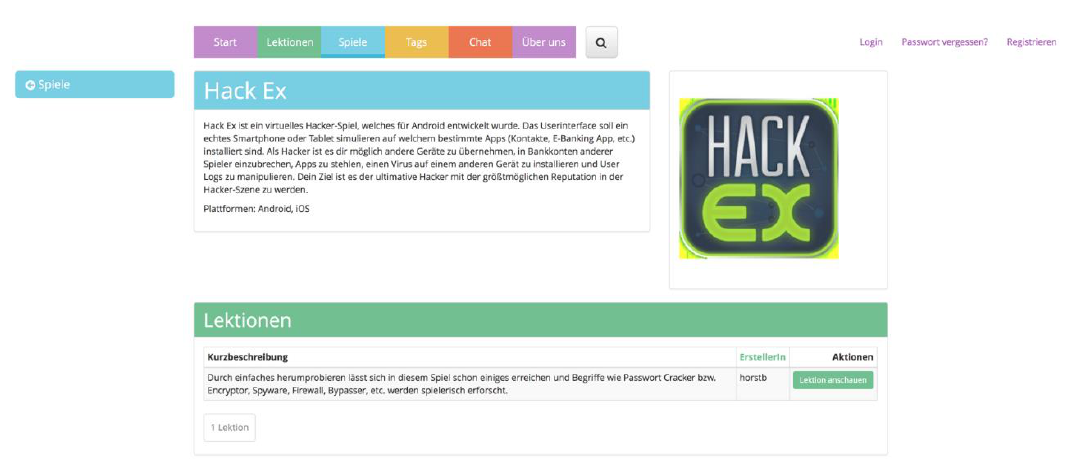
Figure 1. Entry for the game “Hack Ex” in the Sparkling Games database .